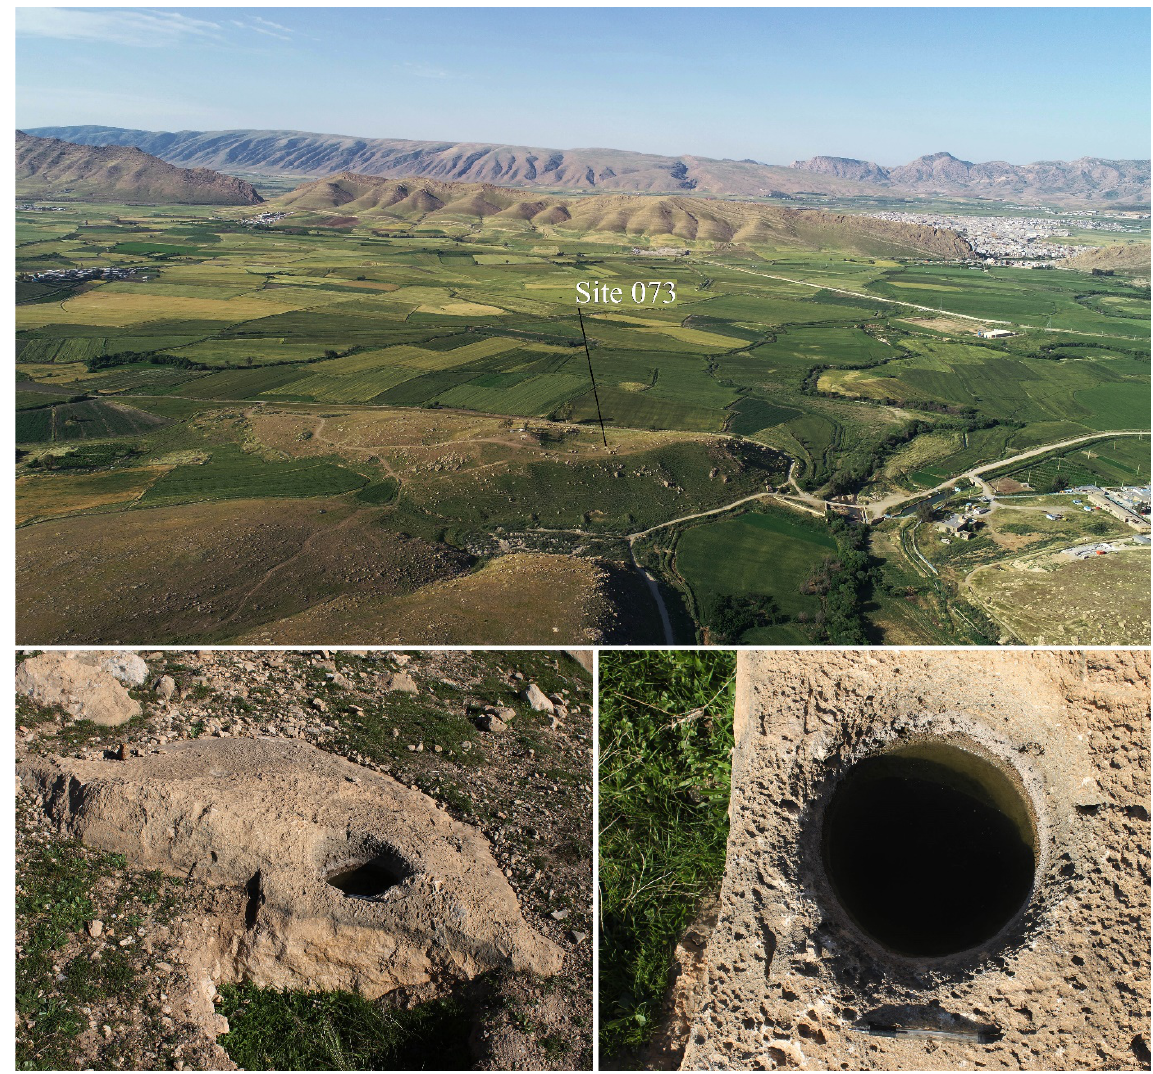
Figure 4. Aerial view of Tapeh Imam Mohammad and its rock mortar (courtesy of Reza